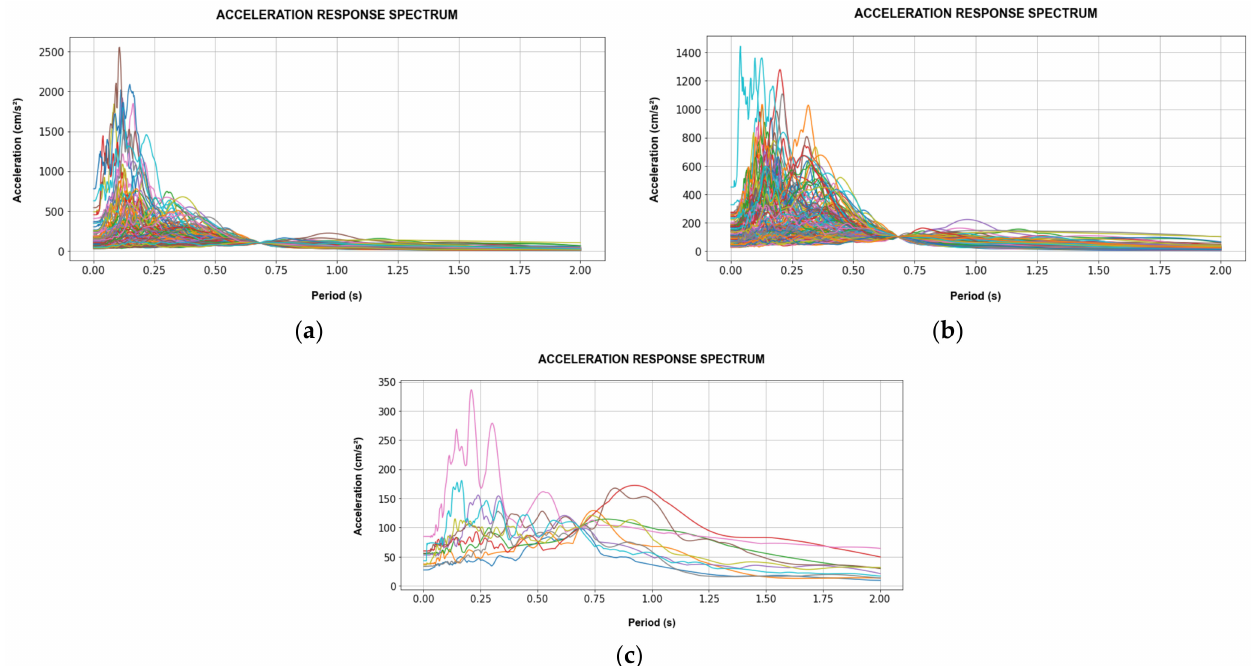
Figure 12. Acceleration response spectrum of Tahara City Hall Building at T 1 = 0.681 s and Sa(T 1 ) = 100 gal. ( a ) Training records for SD; ( b ) Training records for AA; ( c ) Validation records for SD and AA analyses.